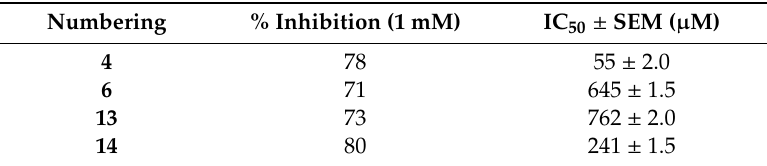
Table 3. Antioxidant activity of the active